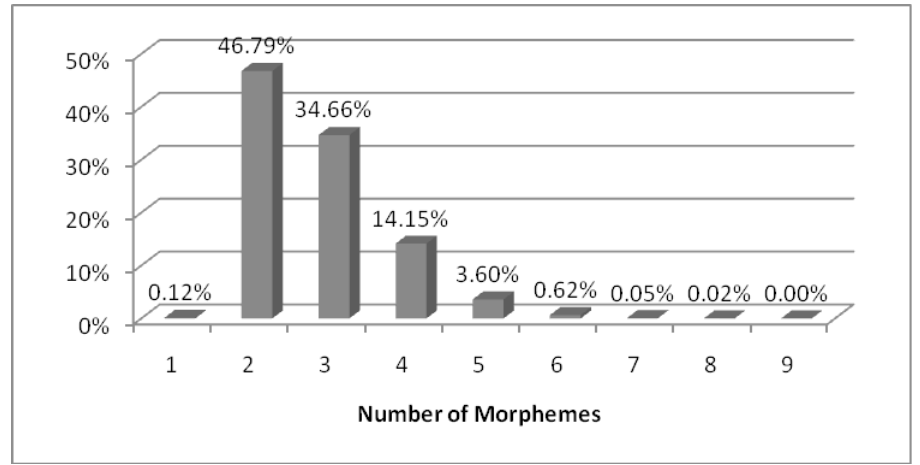
Figure 2. Percentage of Nouns with a Different Number of Morphemes Uni-morphemic nouns are uninflected international words, e.g. meniu, ego, interviu (R model11, 0.1% of all